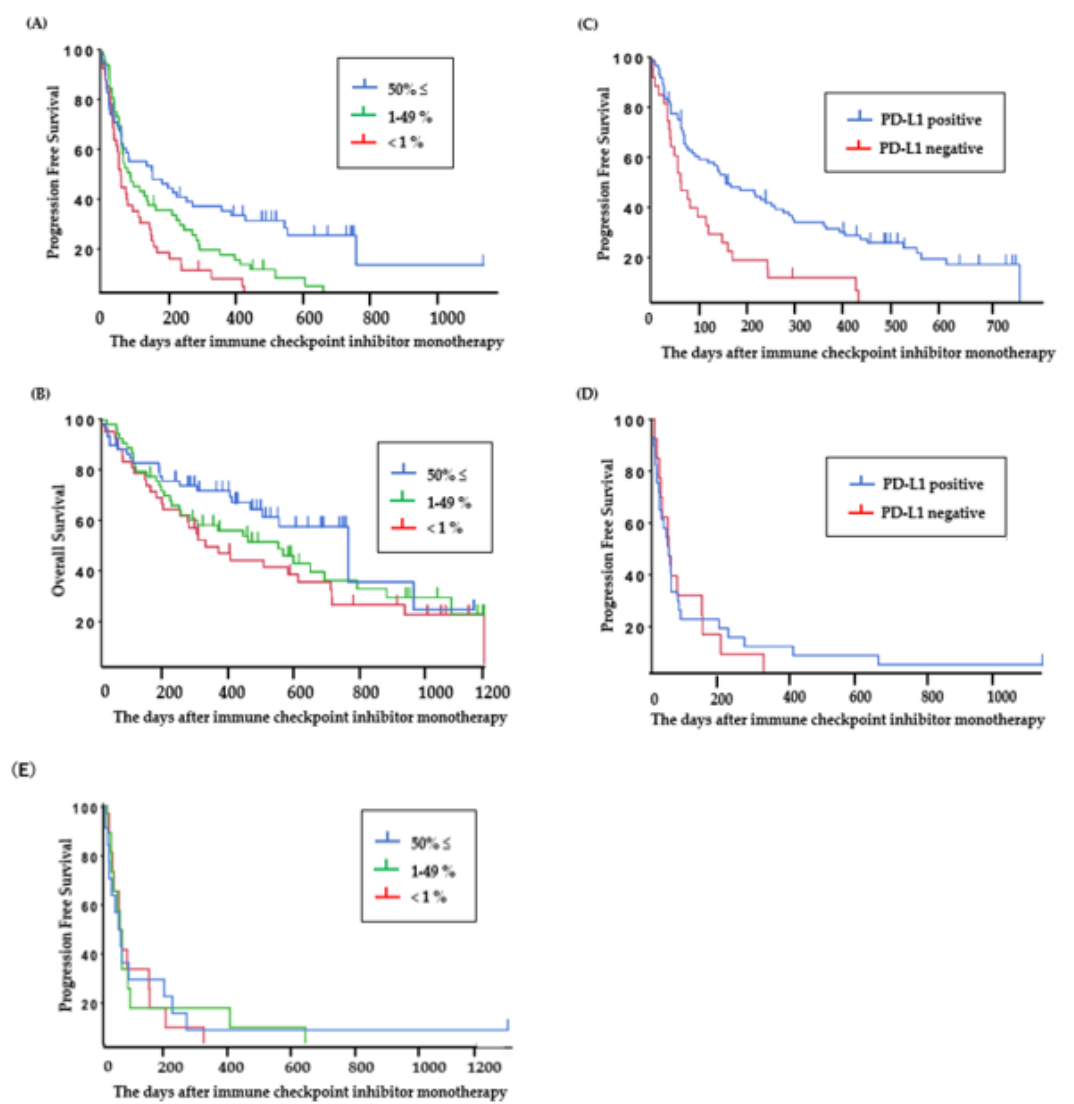
Figure 3. Clinical outcomes in patients treated with ICI. ( A ) Progression-free survival and ( B ) overall survival based on PD-L1 status in all patients viable for PD-L1 assessment (N = 151). ( C ) Progression-free survival based on PD-L1 status in patients without EGFR or ALK mutations (N = 141) and ( D , E ) with EGFR or ALK mutations (N = 54).